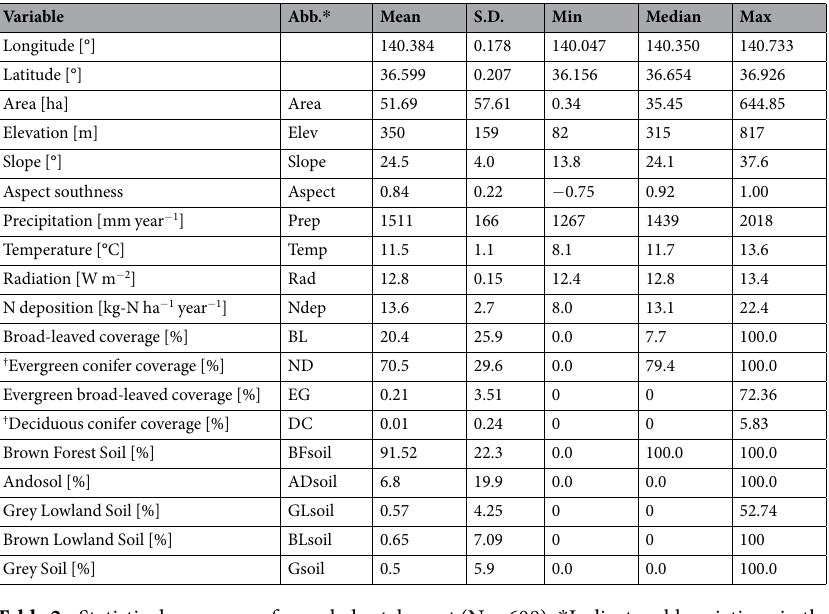
Abbreviations of each variable and statistical summary for the sampled catchment properties from GIS and CMAQ outputs are shown in Table 2. Statistical analysis. To predict catchment-to-catchment variations in − NO mental variables (summarized in Table 2) and evaluate their relative importance, we used a random forest algo- rithm 47 using the randomForest package 48 in the R environment 49 . We used a total of 400 data (randomly selected)